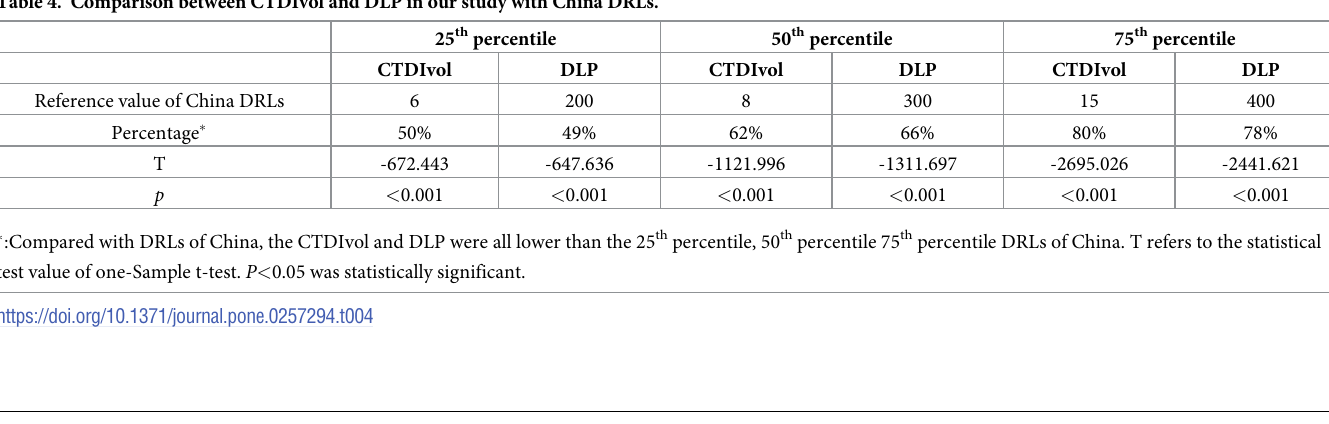
The CTDIvol, DLP, and SSDE of chest CT examinations increased as the patient size increased in this study, and there were strong positive correlation for both CTDIvol and SSDE with Dw. This was expected because in this study, all subjects used automated exposure control for chest CT examination (care dose 4D and care KV). Both image quality and radiation dose depended on the size and shape of patient and scanner parameter [21]. To achieve the compa- rable image quality, larger patients needed higher doses. The radiation dose increased as the patient body size increased. This finding was consistent with findings reported in previous studies [22–24]. In the study which used fixed tube current (FTC) and tube current modula- tion (TCM) on SSDE and image quality in lung cancer screening CT, Barreto [24] demon- strated that SSDE increased exponentially as patient size increased, and all images were still deemed clinically acceptable. Furthermore, we found that the radiation exposure dose for chest CT examinations in our study was lower than China DRLs and updated 2017 ACR DRLs. This finding can also be explained by automated exposure control. A phantom study used TCM in thoracic and abdominal–pelvic imaging yielded significant radiation dose reduc- tion [25]. Care dose 4D is an automated exposure control method that ensures consistent diag- nostic image quality over all body regions at a reduced dose. Care dose 4D combined three different adaptation methods to optimize imaging quality at the lowest level: (1) automatic adaptation of the tube current to the patient size, (2) automatic adaptation of the tube current to the attenuation of the patient’s long axis, and (3) automatic adaptation of the tube current to the angular attenuation profile measured online for each single tube rotation. Care KV opti- mized the applied dose for the defined image quality level, and reduced the influences owing to the technical limits of the system. To achieve this, care KV adapted the tube voltage and cur- rent. All images include in the study was rated excellent to meet diagnostic requirements by respective reporting physicians in charge of quality control.